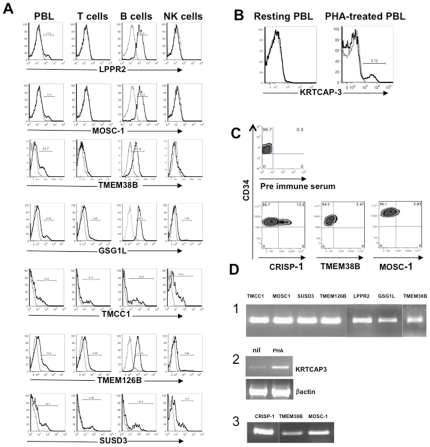
Results of sera screening by FACS on PBL and Cord Blood cells.(A) FACS analysis of sera positive on PBLs. PBLs were stained with the indicated sera at the optimal dilution point (1∶50 to 1∶200). The samples were stained also with anti CD3, anti CD19 and anti CD56 mAbs to analyze the sera reactivity upon gating on the different subpopulations. A plot representative of five different donors is shown for each serum. (B) KRTCAP-3 specific serum recognizes PHA-treated cells. PBMCs are treated for 24 hours with 1 µg/ml of PHA. After the treatment both un-stimulated and treated cells are stained with the KRTCAP-3-specific serum. (C) FACS analysis of sera positive on cord blood cells. Cord blood mononuclear cells are stained with the indicated sera at the optimal concentration (1∶50 to 1∶100). The samples are stained also with anti CD45 and anti CD34 mAbs to perform the analysis upon gating on CD34highCD45dim. A plot representative of a least 3 independent donors is shown. Il all the cases (A,B,C,) a staining with the serum of not immunized mice was used as negative control. (D) RT-PCR analysis. a- cDNA from total PBMC were amplified with primers specific for the indicated proteins. b- cDNA from both un-stimulated and PHA-treated PBMC was amplified with KRTCAP-3 specific primers. KRTCAP3 expression is up regulated two to three times. Beta actin amplification is used as normalization. c- cDNA samples from CD34+CD45dim cells were generated by retro-transcription of RNA extracted from a pool of CD34 positive cells from 2–3 independent cord blood units magnetically purified using the Miltenyi CD34 microbeads kit according the manufacturer instruction. The purity of the CD34+CD45dim cells was usually >99%. The samples were amplified with primers specific for the indicated proteins and described in the Methods section.